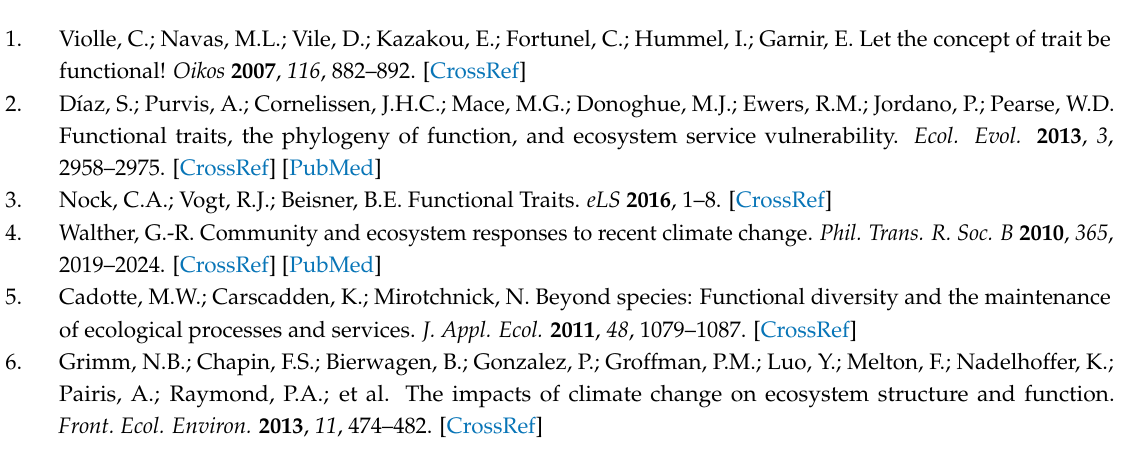
Table S1: Bioclimatic frequency data for beech forests and the geographic region; Figure S1: Climatic response traits of beech forests based on 21 bioclimatic variables; Figure S2: ROC curves and AUC values of beech forests based on 21 bioclimatic